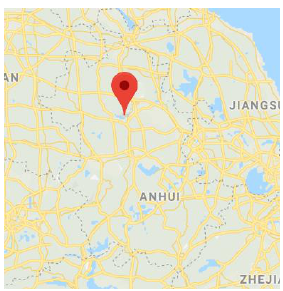
Figure 1. The geographical location of